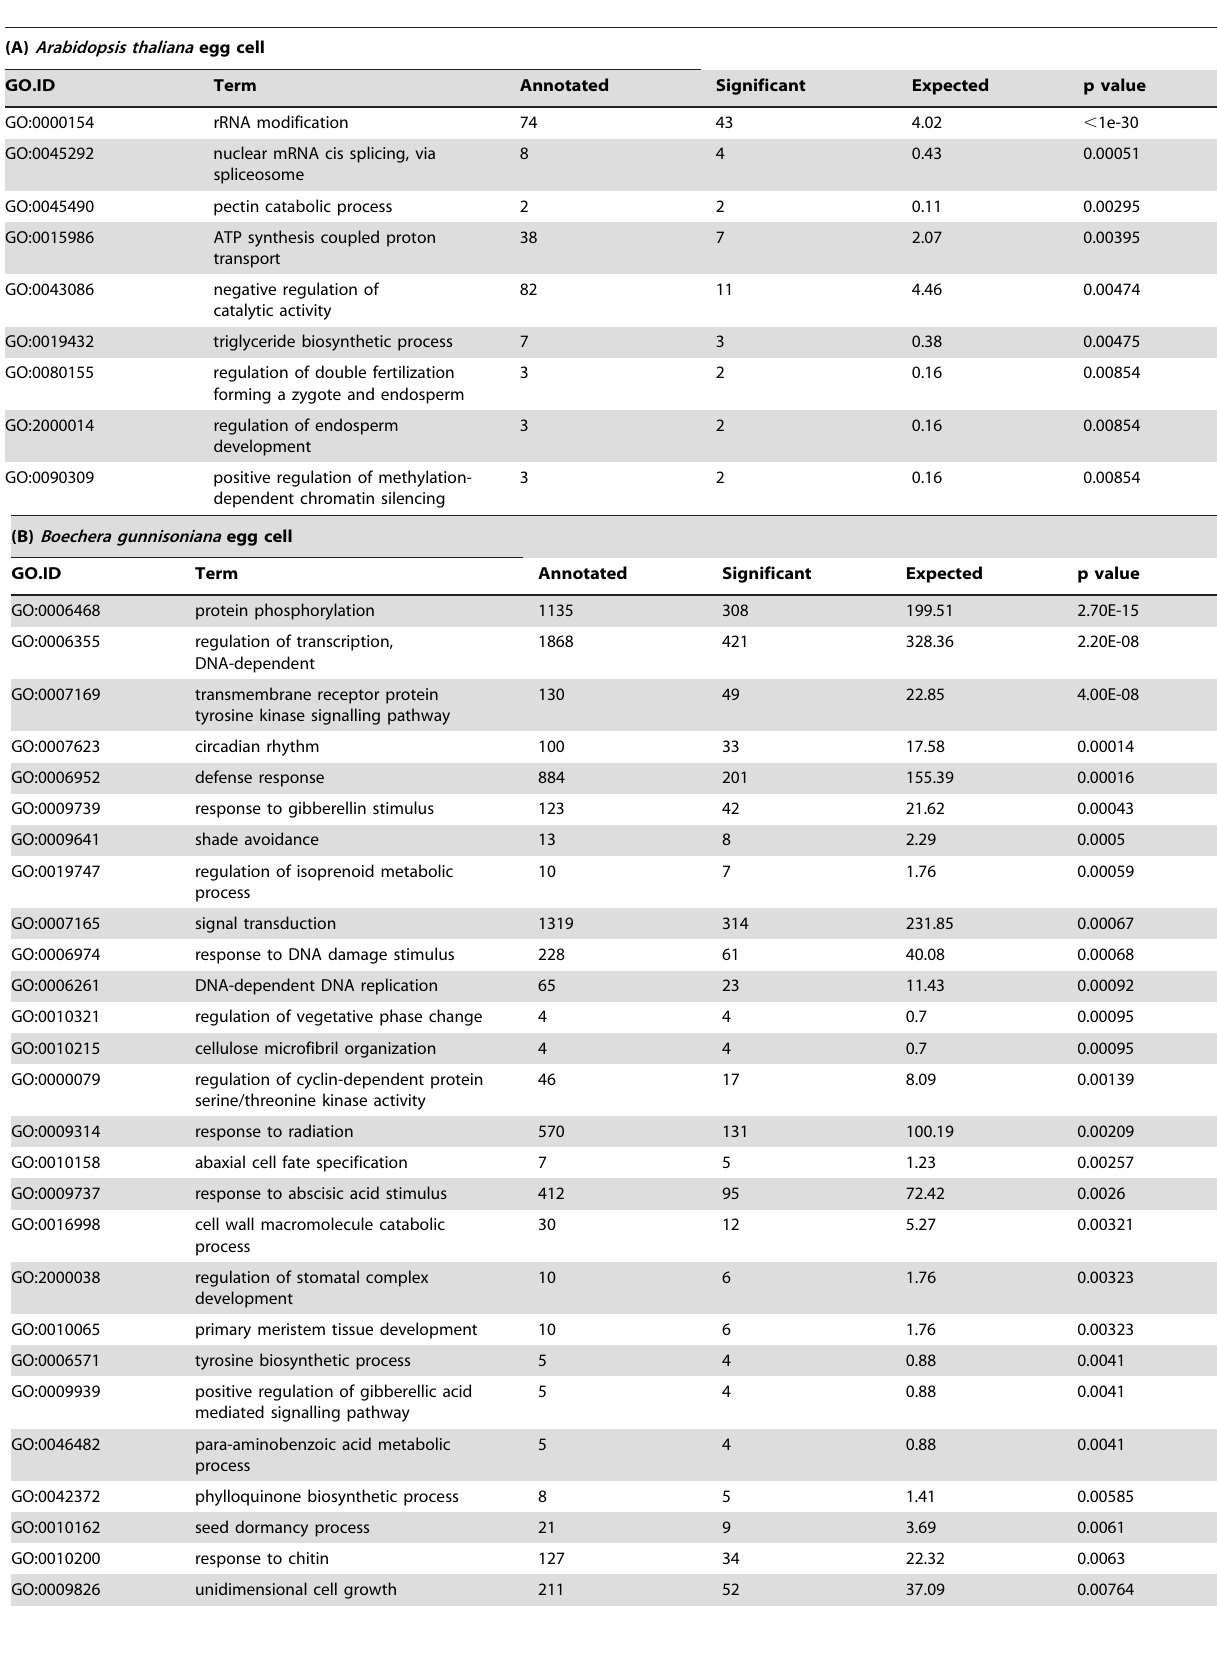
Table 4. Gene ontology analysis on sexual and parthenogenetic egg cells of Arabidopsis and Boechera , respectively.